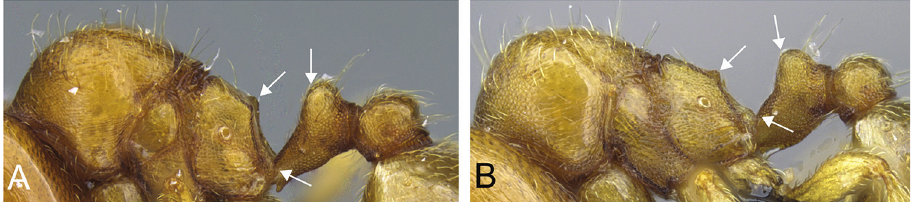
Figure 19. Mesosoma, petiole and postpetiole in profile view of A Carebara vazimba (CASENT0055532) B Carebara kabosy